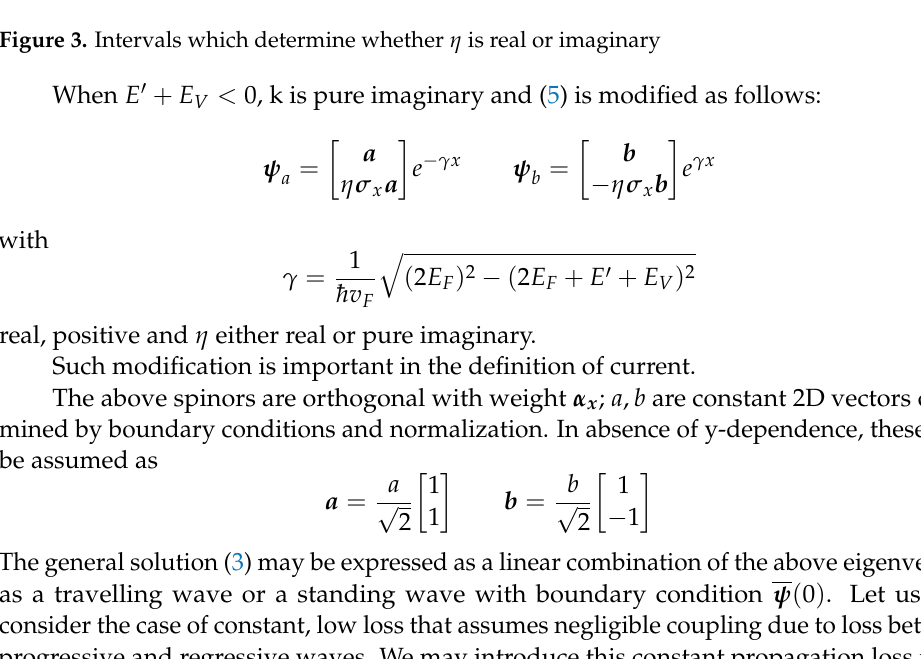
(cid:113) 1 ( 2 E ) 2 − ( 2 E γ = F ¯ hv F